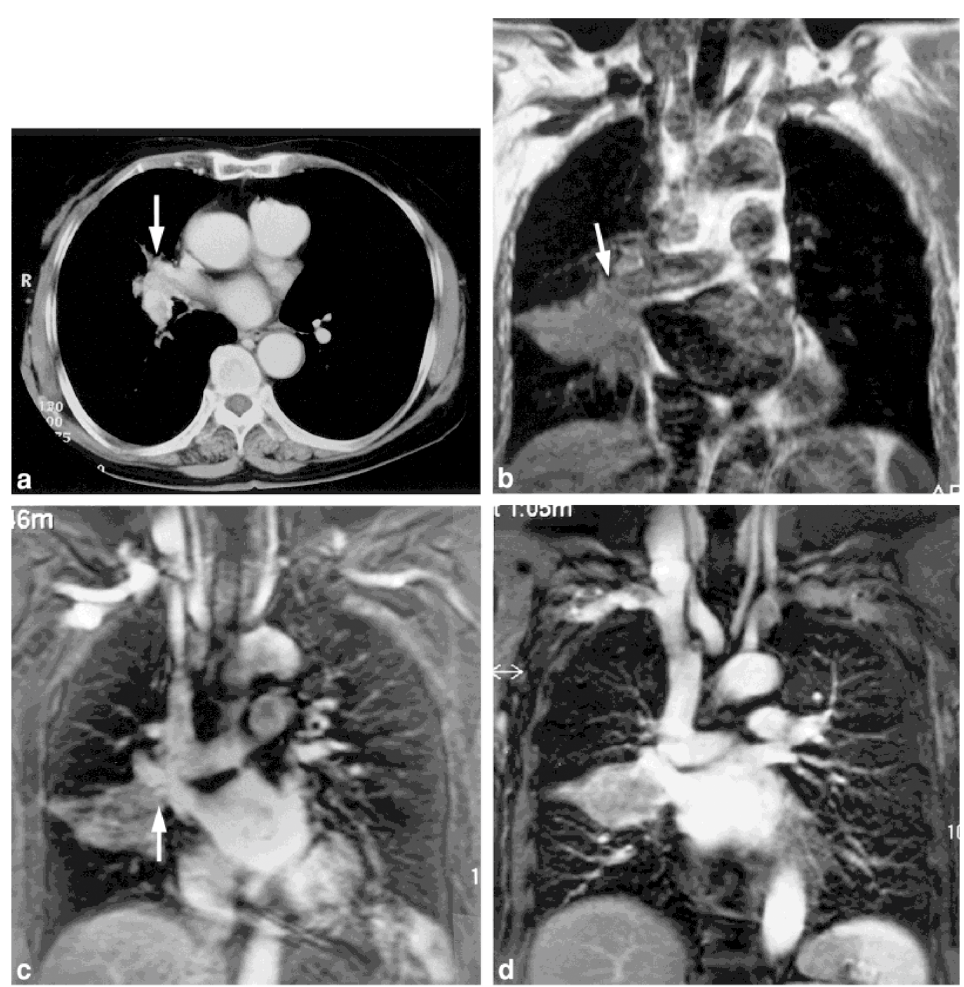
Figure 1. A 75-year-old man with squamous cell carcinoma in the middle lobe (permission obtained from reference #21). ( a ) Contrast-enhanced CT image demonstrates invasion of the truncus interlobar pulmonary artery and right superior pulmonary vein by the tumor (arrow). ( b ) ECG-gated T1-weighted SE image shows stenosis of the truncus interlobar pulmonary artery. Moreover, the flow-related enhancement within the right superior pulmonary vein (arrow) resembles invasion. ( c ) Conventional MRA image reveals irregularities in the wall of the superior pulmonary vein (arrow). Invasion of the right superior pulmonary vein by the tumor was also suspected. Cardiac motion artifacts have degraded the image quality. ( d ) ECG-triggered MRA image clearly shows the smooth vessel wall of the right superior pulmonary vein, with no invasion of this vein detected. Right bilobectomy was performed, and invasion of the superior pulmonary vein was not observed during